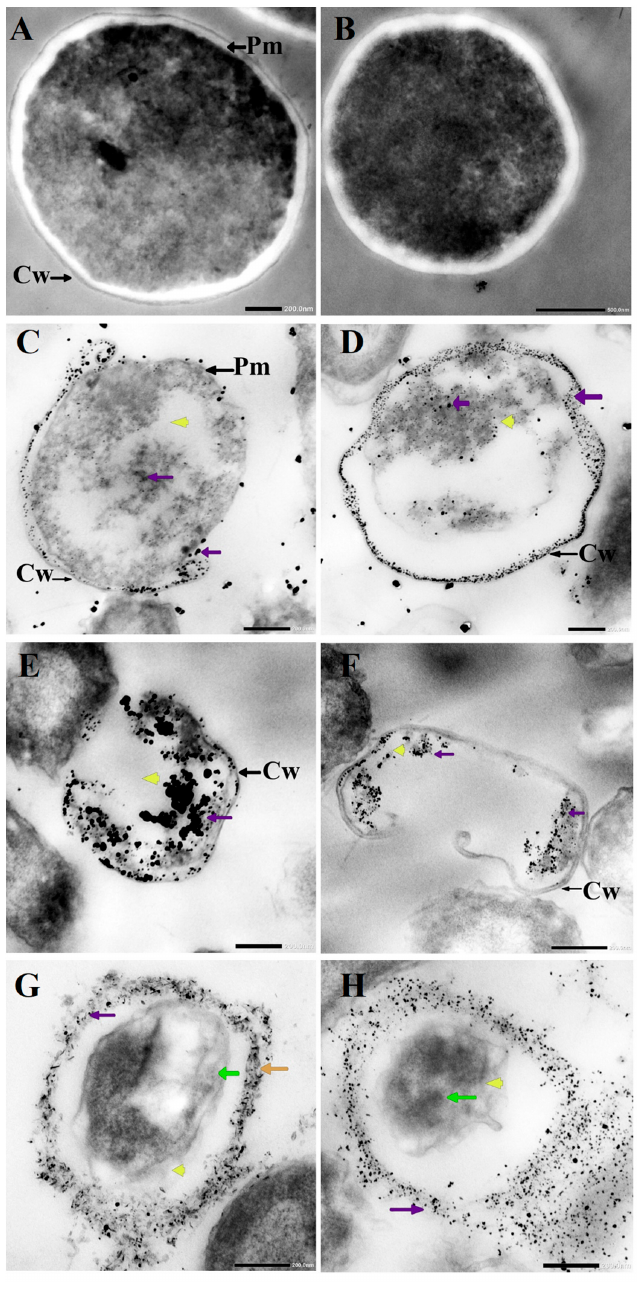
Figure 3. TEM micrographs of untreated Candida albicans exhibiting an intact cell wall (Cw) and intact plasma membranes (Pm) ( A , B ). TEM micrographs of C. albicans treated with 1.5 mg/mL AgNO 3 showing the disruption of the cell wall (Cw) and folded membranes, the detachment of cellular membranes (Pm) around the cytoplasmic matrix, moderate cytoplasmic dissolution (yellow arrow- head), and deposition of dark spherical granules believed to be Ag-NPs synthesized by C. albicans itself (violet arrow) ( C , D ). TEM micrographs of C. albicans treated with 1.5 mg/mL D-SNPs showing the degradation of the cell wall (Cw), shrinkage, cellular membranes with dark, dense spherical particles thought to be D-SNPs (violet arrow), and severe cytoplasmic lashing (yellow arrowhead) ( E , F ). TEM micrographs of C. albicans treated with 1.5 mg/mL N-SNPs showing cell envelope lysis (orange arrow), severe cytoplasm lashing (yellow arrowhead), nucleoagglutination (yellow arrow), and distribution of dark, dense, spherical particles thought to be D-SNPs (violet arrow). ( G , H ) Scale bars: 200 and 500